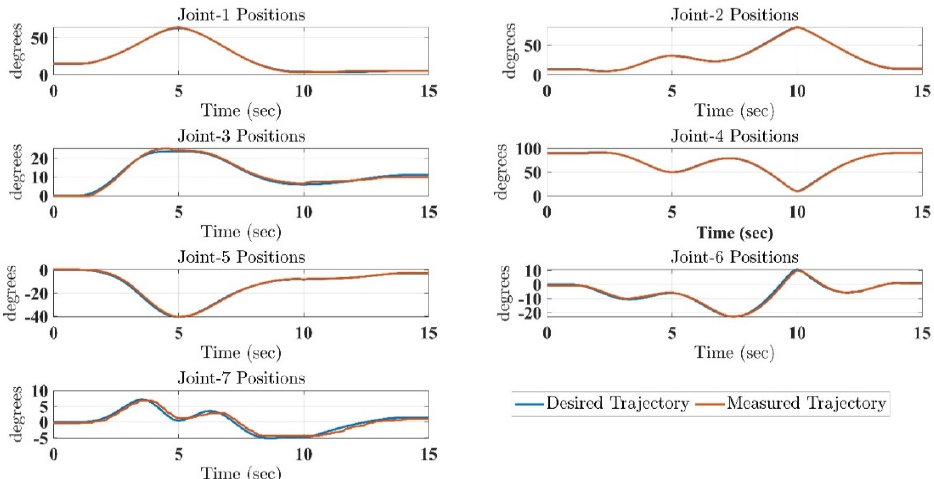
Figure 11. SREx trajectory tracking performance in joint space under the conventional super-twisting controller.